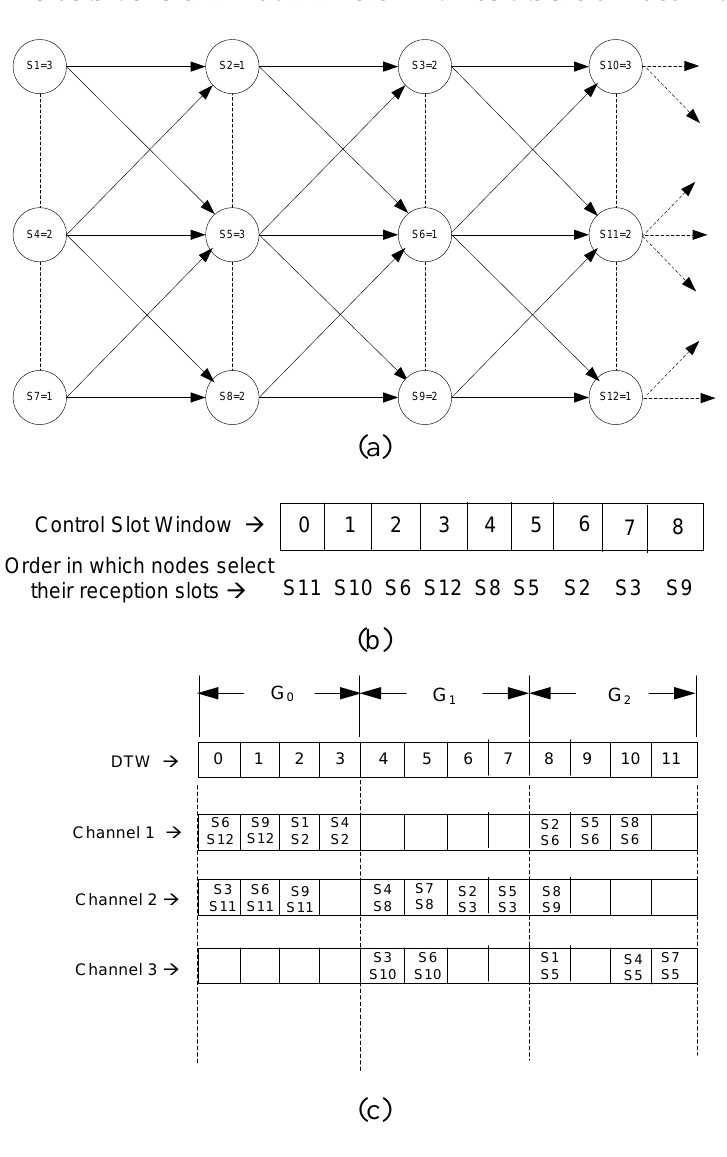
Figure 2. An example of transmission schedule for the proposed Multi-channel MAC protocol. (a) Topology with the node ID and receiving channel; (b) Control slot window and the order in which each node selects its reception schedule; (c) Allocated slots with three channels in a data transfer window where 12 timeslots are divided into three